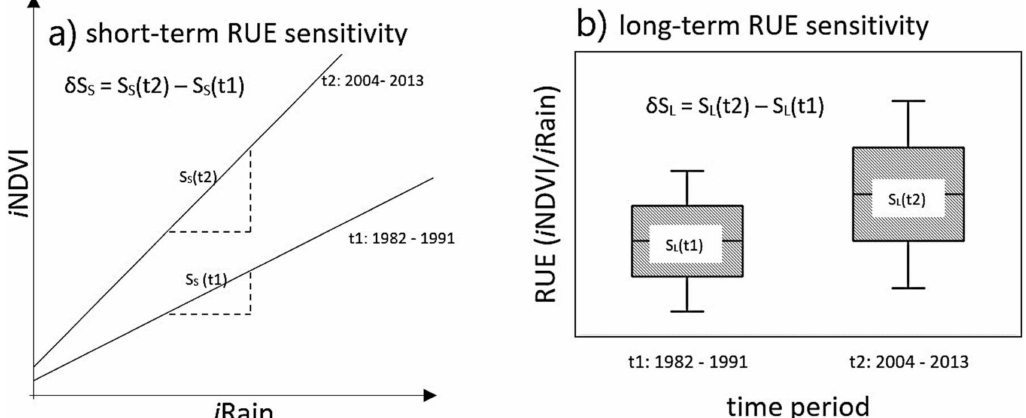
Figure 3. Conceptual framework for diagnosing per-pixel trends in separate woody and herbaceous vegetation (see [34] for details). ( a ) Change in short-term rain use efficiency (RUE) sensitivity ( δ S S ) is the difference in slope (S S ) of the i NDVI/ i Rain relationship between 2 periods (t1, t2). δ S S is rainfall. ( b ) Change in long-term RUE sensitivity ( δ S L ) is the difference in long-term mean of